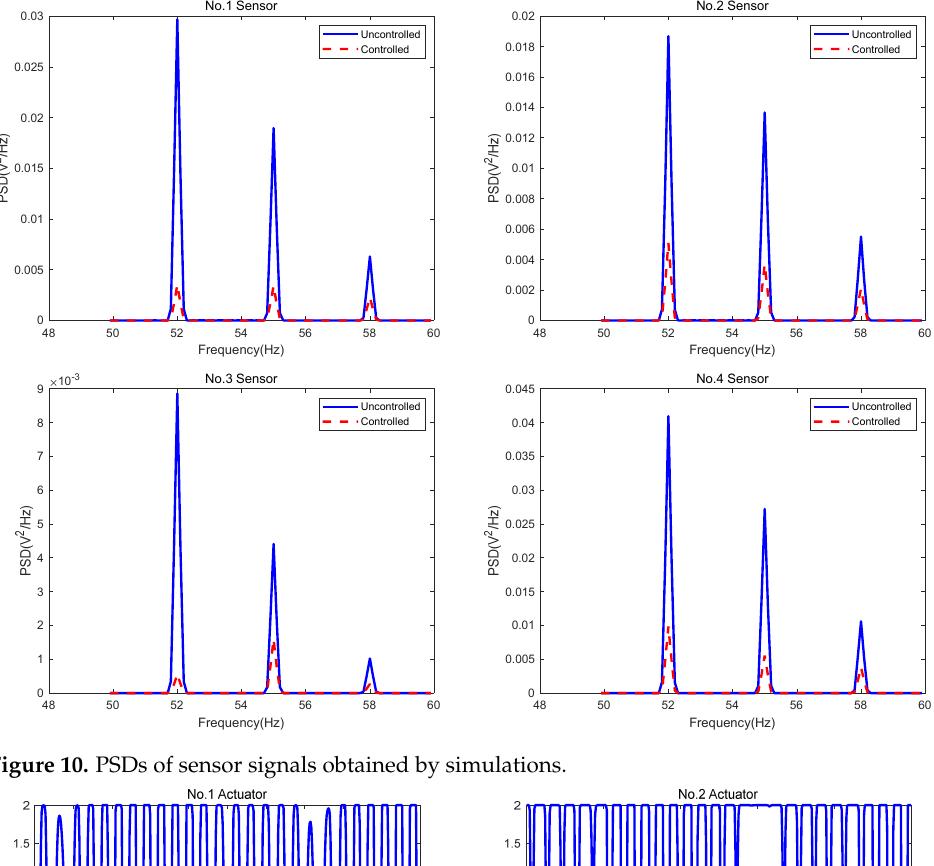
Figure 9. Sensor signals obtained by simulations (1 mV represents 0.1 m/s 2 ).